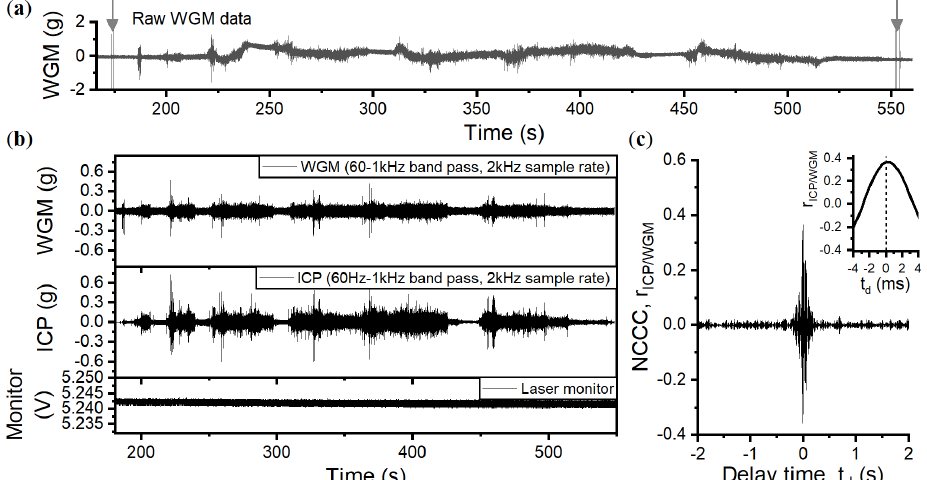
Figure 7. ( a ) Raw data of the WGM accelerometer during field-testing. Arrows show the hammer shocks that indicate the start and finish of the trial. ( b ) The WGM and ICP data are band pass filtered (60Hz–1kHz) and decimated to a 2kHz sampling rate (data below 60Hz are unreliable due to the effect of the feedback). The laser monitor signal shows negligible changes in laser power due to acceleration. ( c ) The cross-correlation for the filtered data is r ICP/WGM =